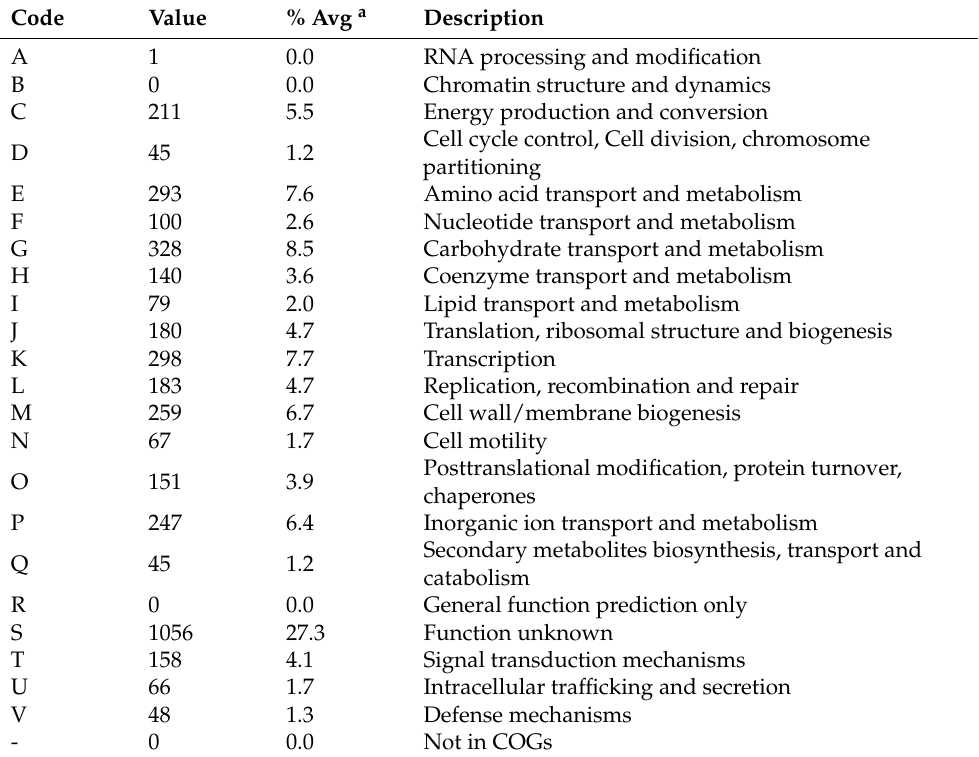
Table 3. Summary of the number of genes and percentage of the genes (averages) that are associated with COG functional categories found among the 33 C. sakazakii strains evaluated in this